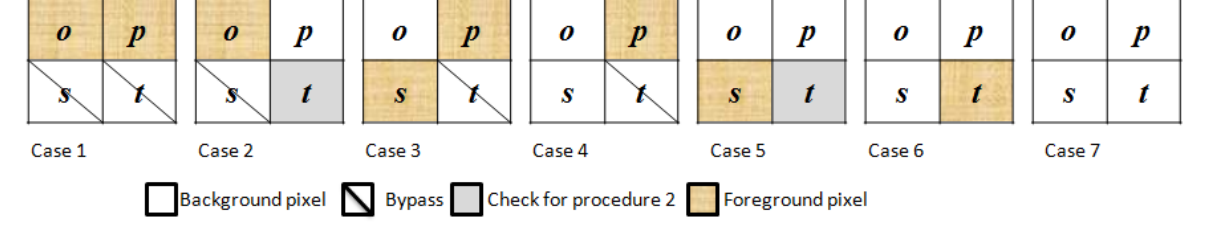
Figure 5. The seven selected cases of the current block for procedure